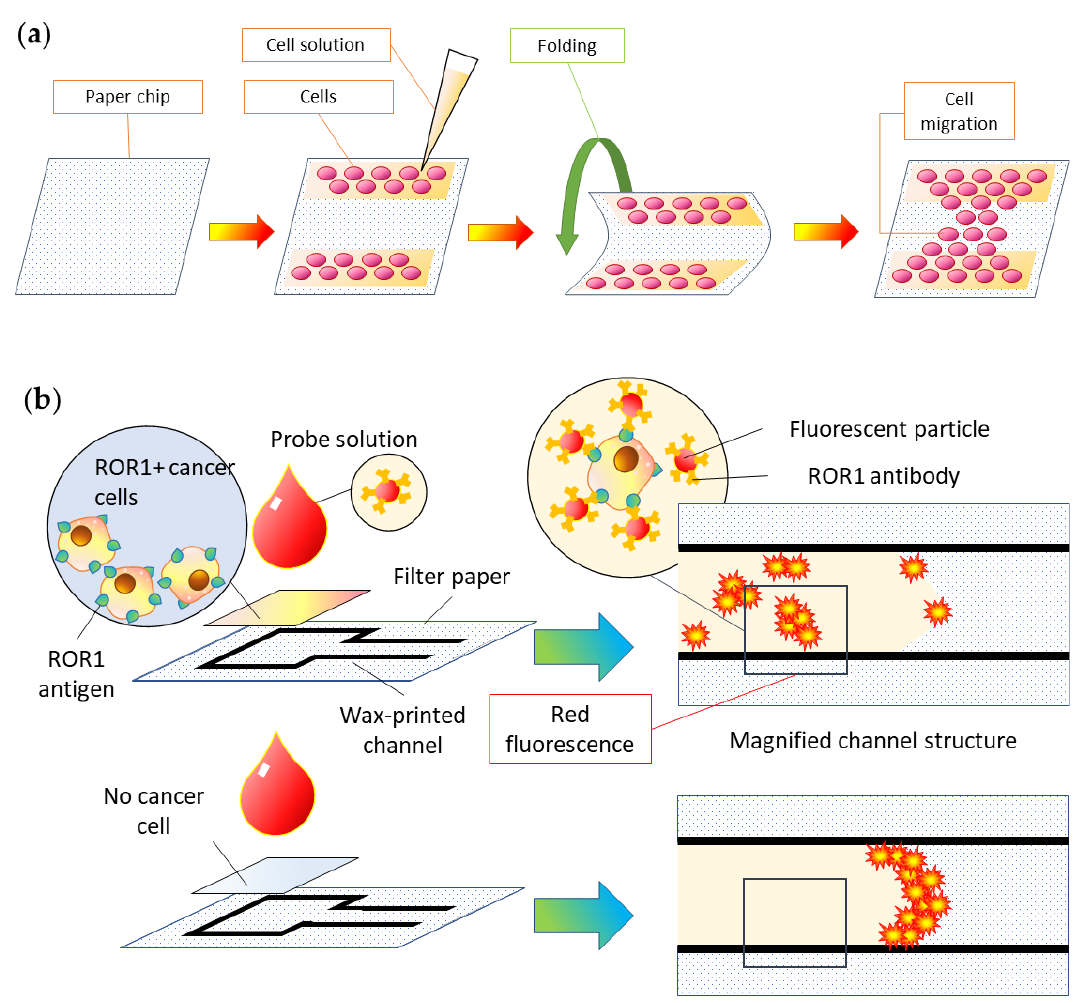
Figure 7. Paper chip-based cell analysis. ( a ) Cell stress stimulation device developed by Kaarj et al. [105]; ( b ) ROR1+ cancer cell capture paper chip developed by Ulep et al. [58].